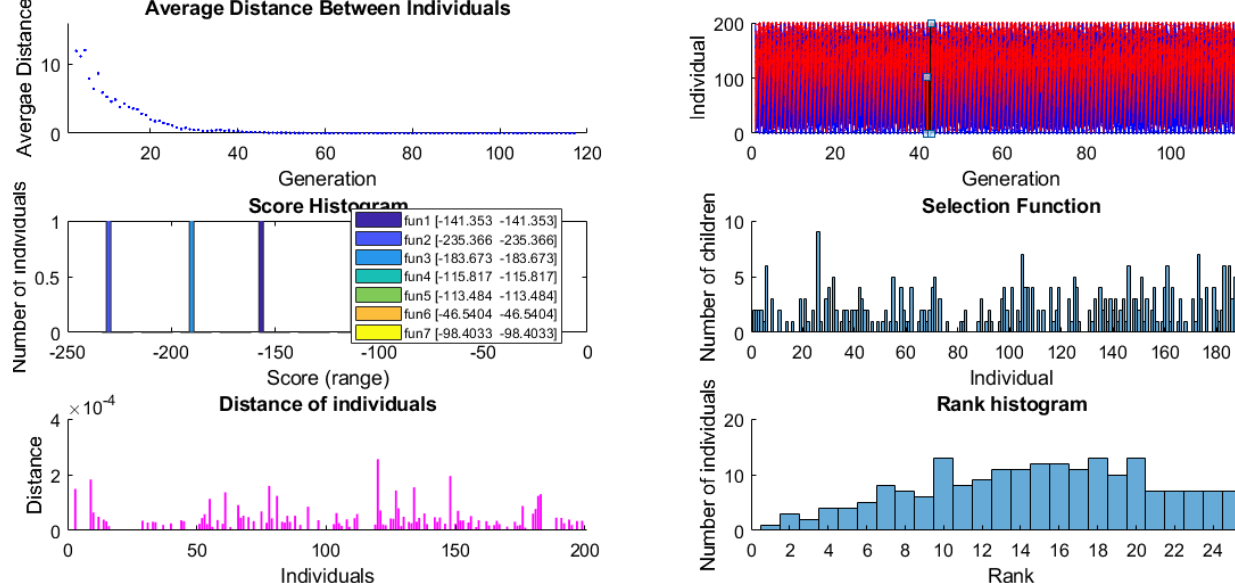
Figure 12. Results showing HNN enhanced GA features and